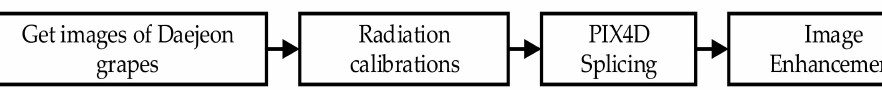
Figure 3. Data preprocessing technology